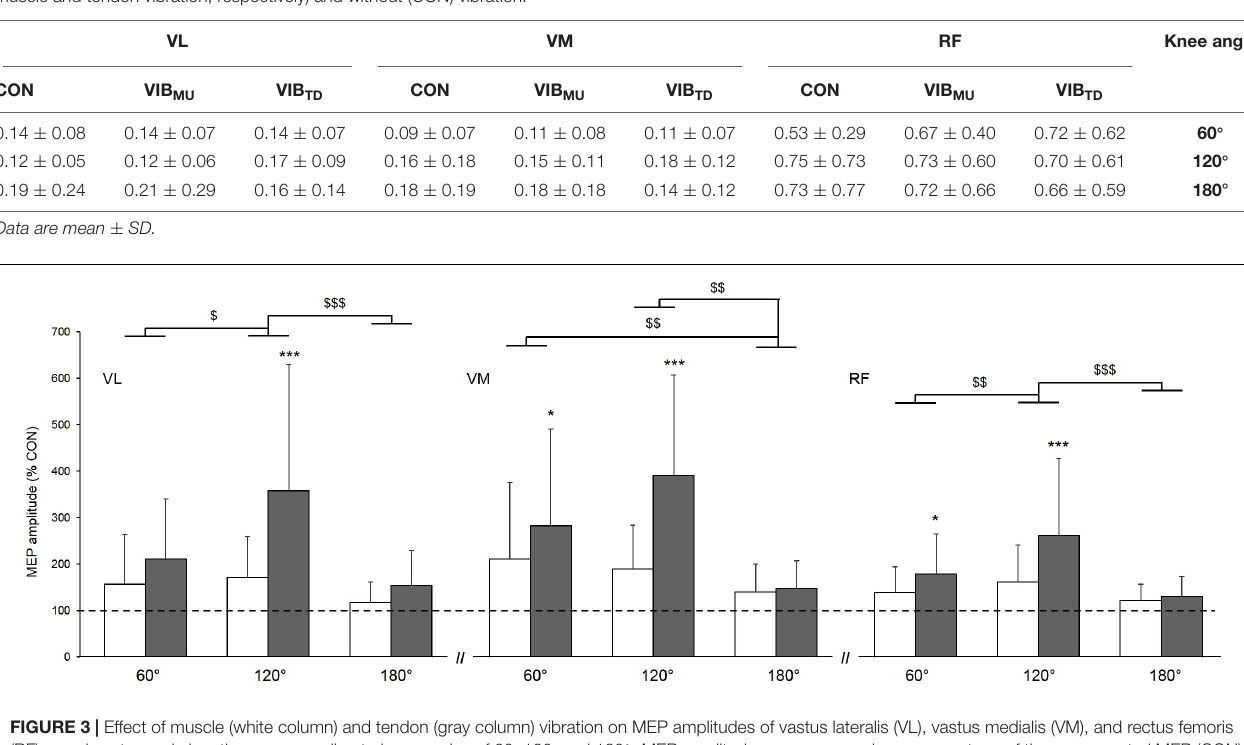
Thus, whether or not changes in vibration characteristics